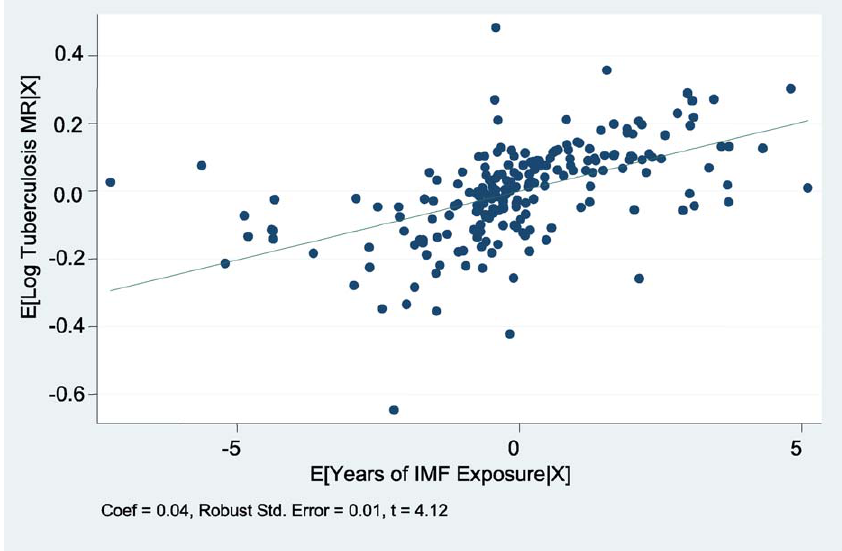
Figure 5. Adjusted Association of Years of IMF Exposure on Log Tuberculosis Mortality